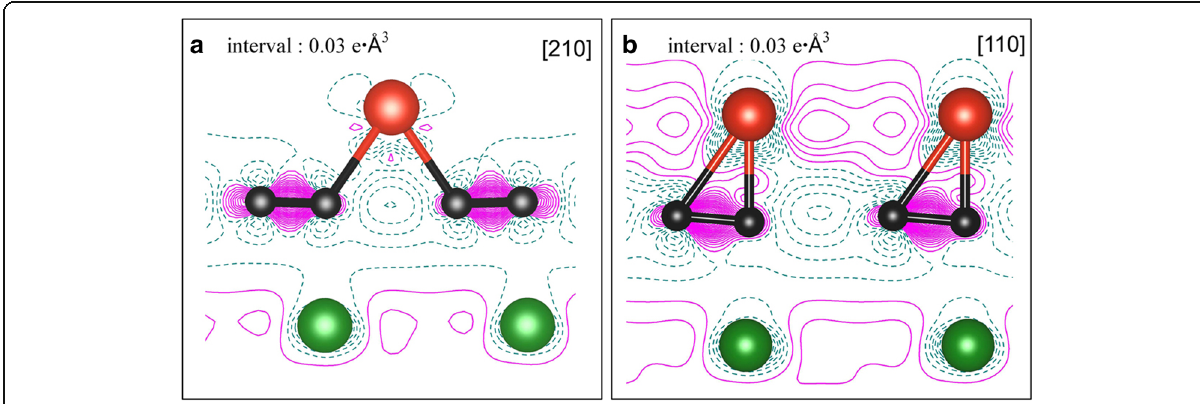
Fig. 10 Deformation charge densities for the adsorption of V atoms on the graphene-covered Cu(111) surface at two coverages, i.e., a 1/9 ML and b 1 ML. Electron accumulation and depletion are represented by magenta solid lines and green dashed lines, respectively. The green, black, and red balls represent Cu, C, and V atoms,